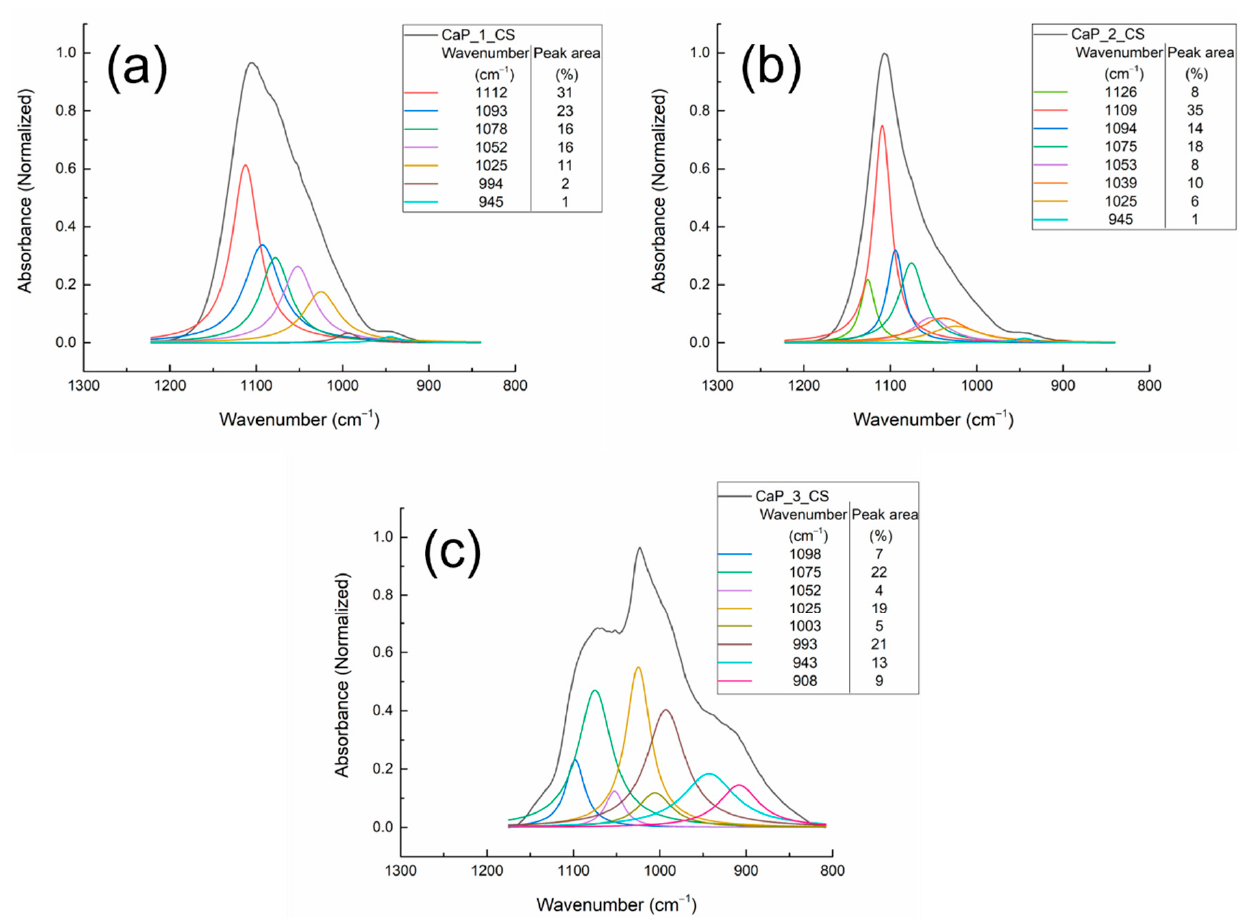
Figure 12. Deconvoluted FTIR spectra of the ( a ) CaP_1_CS, ( b ) CaP_2_CS, and ( c ) CaP_3_CS in the 1300–800 cm − 1 wavenumber range. Table 3. The assignment of FTIR absorption bands for the CaP and CaP_CS coatings.